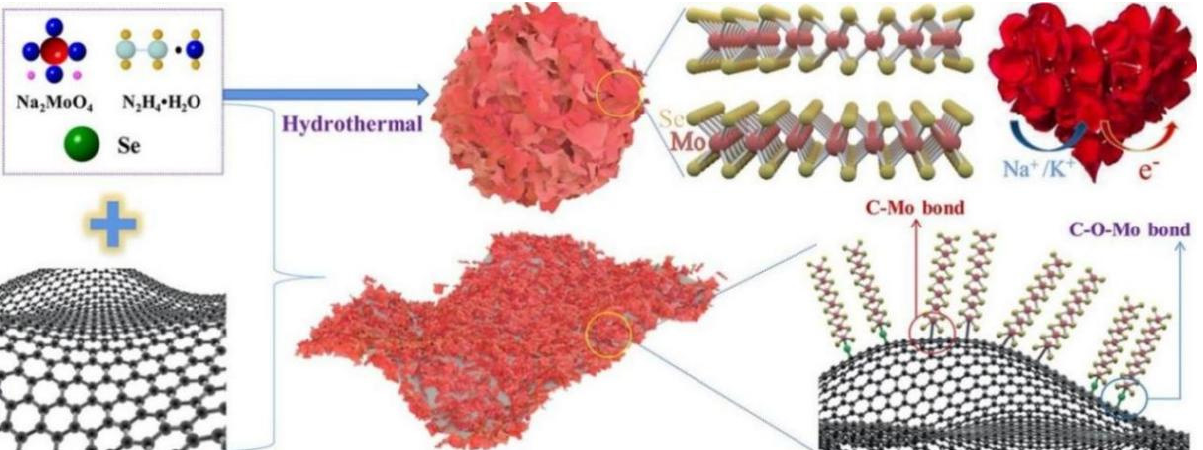
Figure 4. Schematic illustration of the synthetic procedure: MoSe 2 nanosheets perpendicularly deposition onto the surface of rGO (MoSe 2 @rGO). Reproduced with permission [65]. Copyright 2021, American Chemical Society.